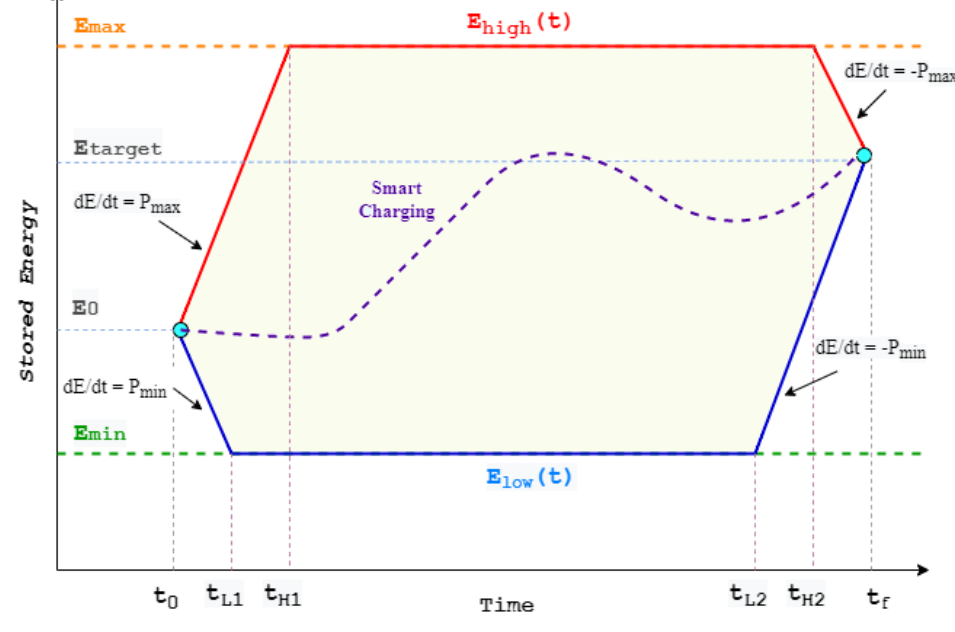
Figure 2. Bounds of PEV’s stored energy.